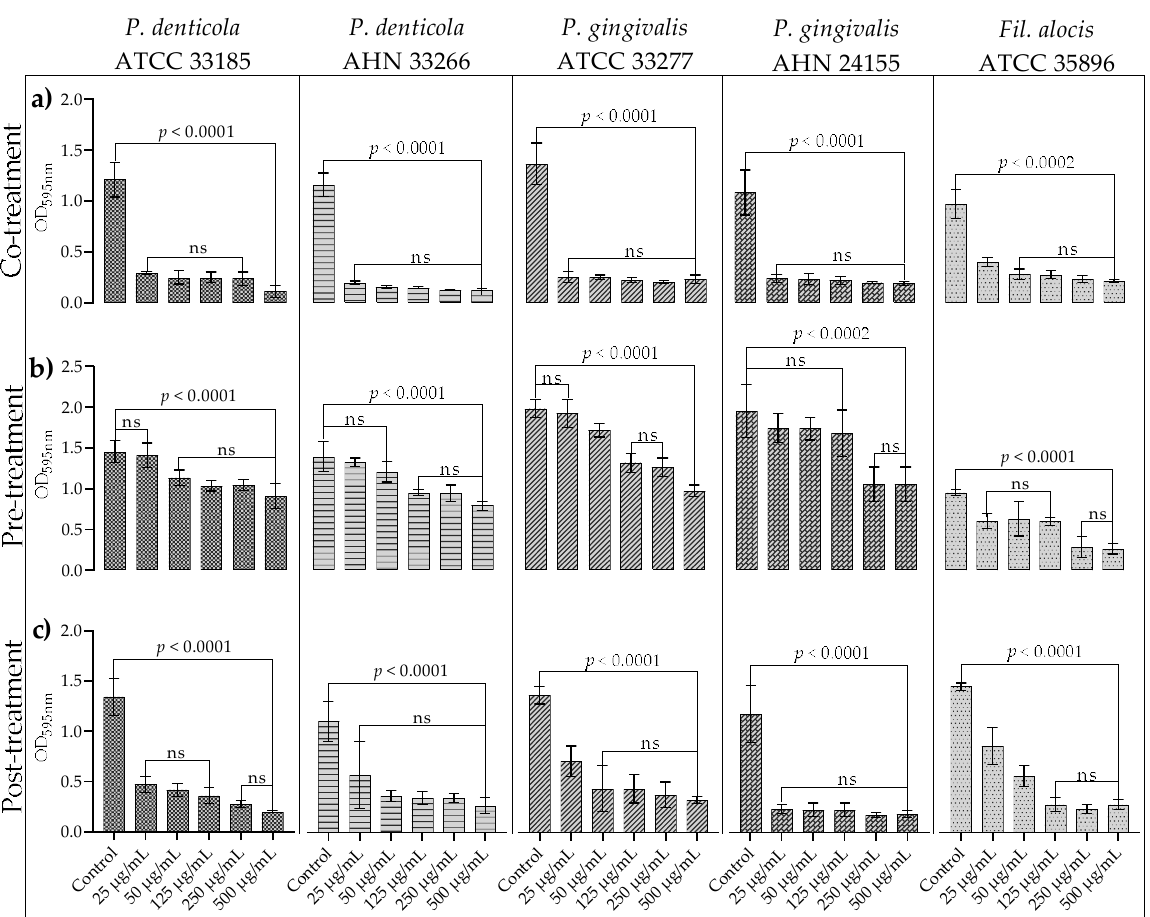
Figure 2. Antibiofilm activity of EPSs. All biofilms are dual-species biofilms including F. nucleatum ATCC 25586. Co-treatment assay: Biofilm formation in culture media adjusted with different con- centrations of EPSs. ( a ) P. denticola ATCC 33185, P. denticola AHN 33266, P. gingivalis ATCC 33277, P. gingivalis AHN 24155, Fil. alocis ATCC 35896, respectively, in row a . Pre-treatment assay: Biofilm formation on treated surfaces with different concentrations of EPSs ( b ) P. denticola ATCC 33185, P. denticola AHN 33266, P. gingivalis ATCC 33277, P. gingivalis AHN 24155, Fil. Alocis ATCC 35896, respectively, in row b . Post-treatment assay: EPSs treatment with different concentrations on estab- lished biofilms. ( c ) P. denticola ATCC 33185, P. denticola AHN 33266, P. gingivalis ATCC 33277, P. gingivalis AHN 24155, Fil. alocis ATCC 35896, respectively, in row c . ns: not significant. Bars include standard deviation. Y -axis was equalized in each row.